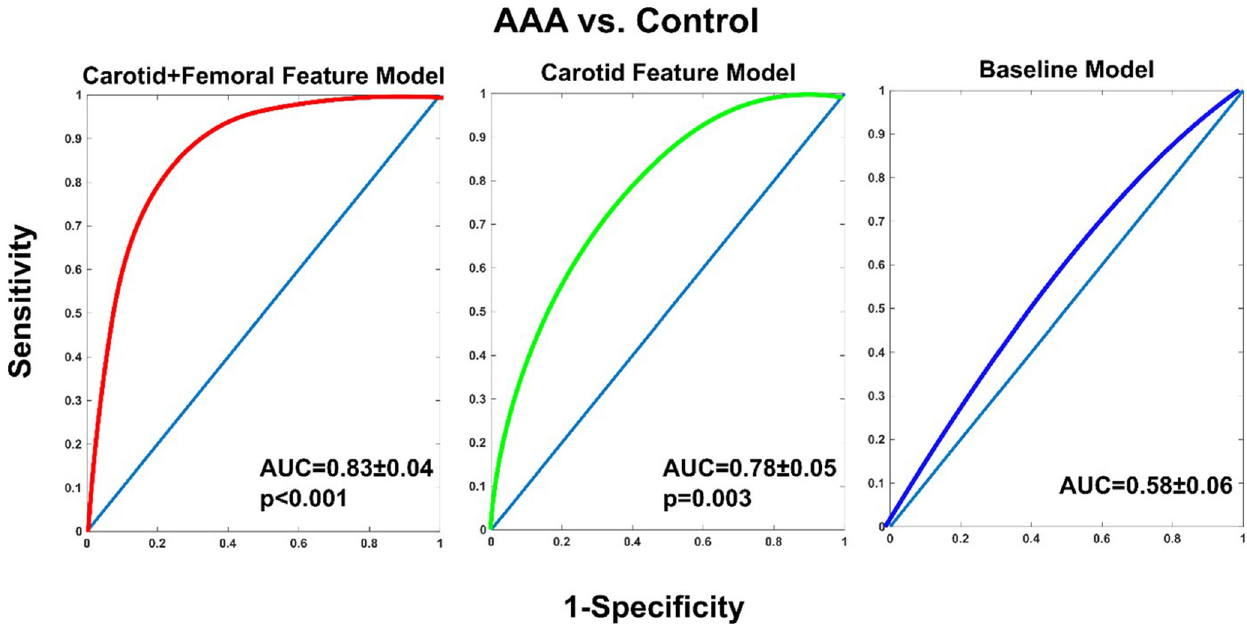
Fig. 6 Classi fi cation results of the 100 leave-one-patient-out maximal aortic diameters predicted by the three models for the 100 AAA (before EVAR) and control patients. Receiver operating characteristic (ROC) curves for classifying AAA versus control patients using the predicted maximal aortic diameters. AUC (mean ± s.e.m) is ROC area under the curve. The two-sided p-values were obtained through comparisons with the baseline model using the Hanley – McNeil test for paired EVAR versus 3 years after EVAR (right panel of fi gure). Consistent